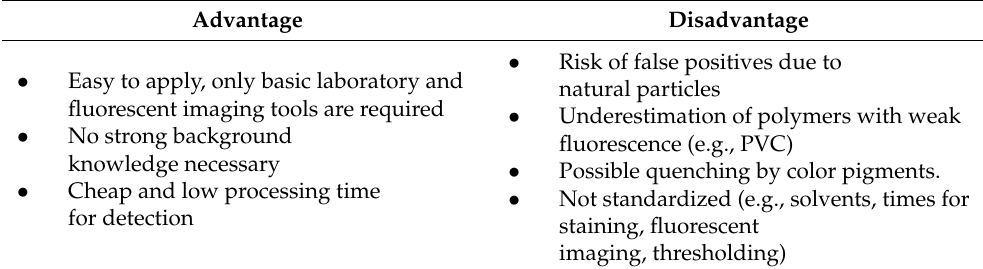
Table 1. Advantages and disadvantages of fluorescent staining for microplastic